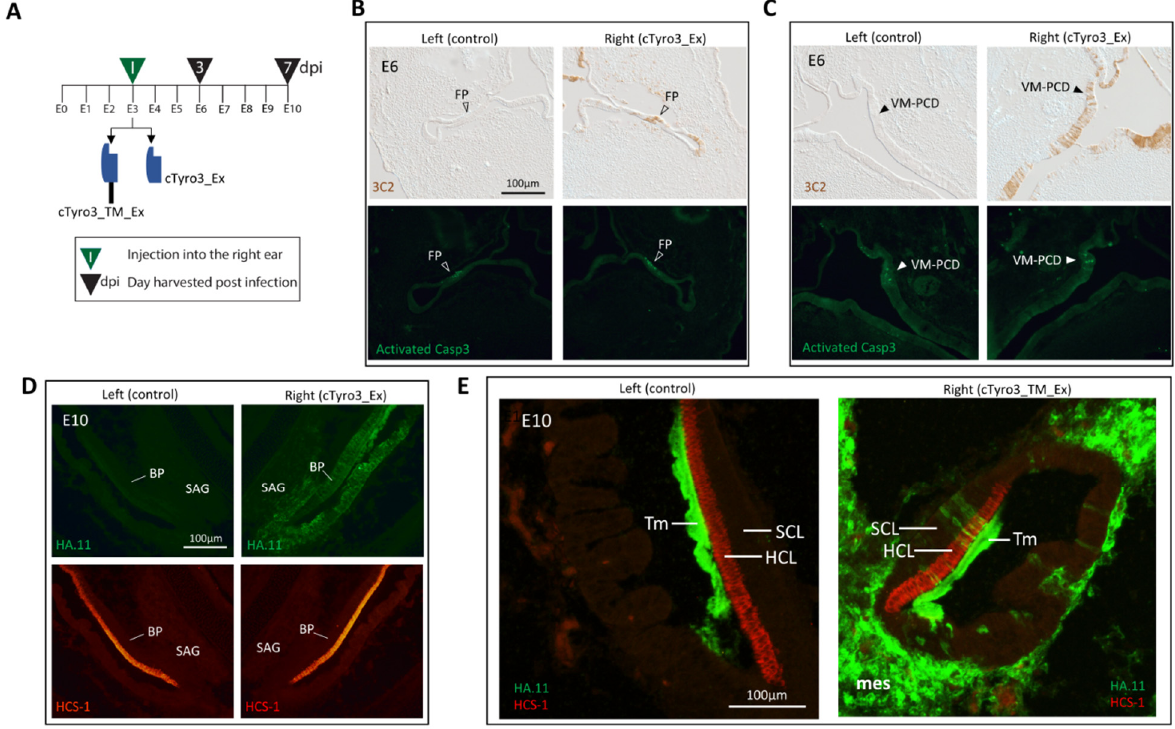
Figure 5. Expression of cTyro3 dominant negatives does not affect cell death and hair cell expression in the inner ear. ( A ) Timeline of experiment. ZIKV was injected on E3 (green triangle) with embryos processed on E3 or E10 (black triangles) ( B – E ) Infection of the right inner ears with RCAS(A) is indicated by immunostaining of viral gag protein with 3C2. Infection does not change immunostaining for activated Caspase 3 in ( B ) the fusion plate (FP) of the lateral canal (open arrowheads) or the ( C ) ventromedial hotspot of programmed cell death (VM-PCD) (closed arrowheads), when compared with the same regions in the uninfected left ear. ( D , E ) Expression of the hair cell marker HCS-1 is unchanged on the infected right side compared to the uninfected left side. In ( E ), the tectorial membrane is non-specifically labelled with HA.11 (green) antibody in both ears. Scale bar = 100 µm. Abbreviations: BP, basilar papilla; dpi, days post-infection; FP, canal fusion plate; HCL, hair cell layer; SAG, statoacoustic ganglion; SCL, supporting cell layer; Tm, tectorial membrane; VM-PCD, ventromedial hotspot of programmed cell death.